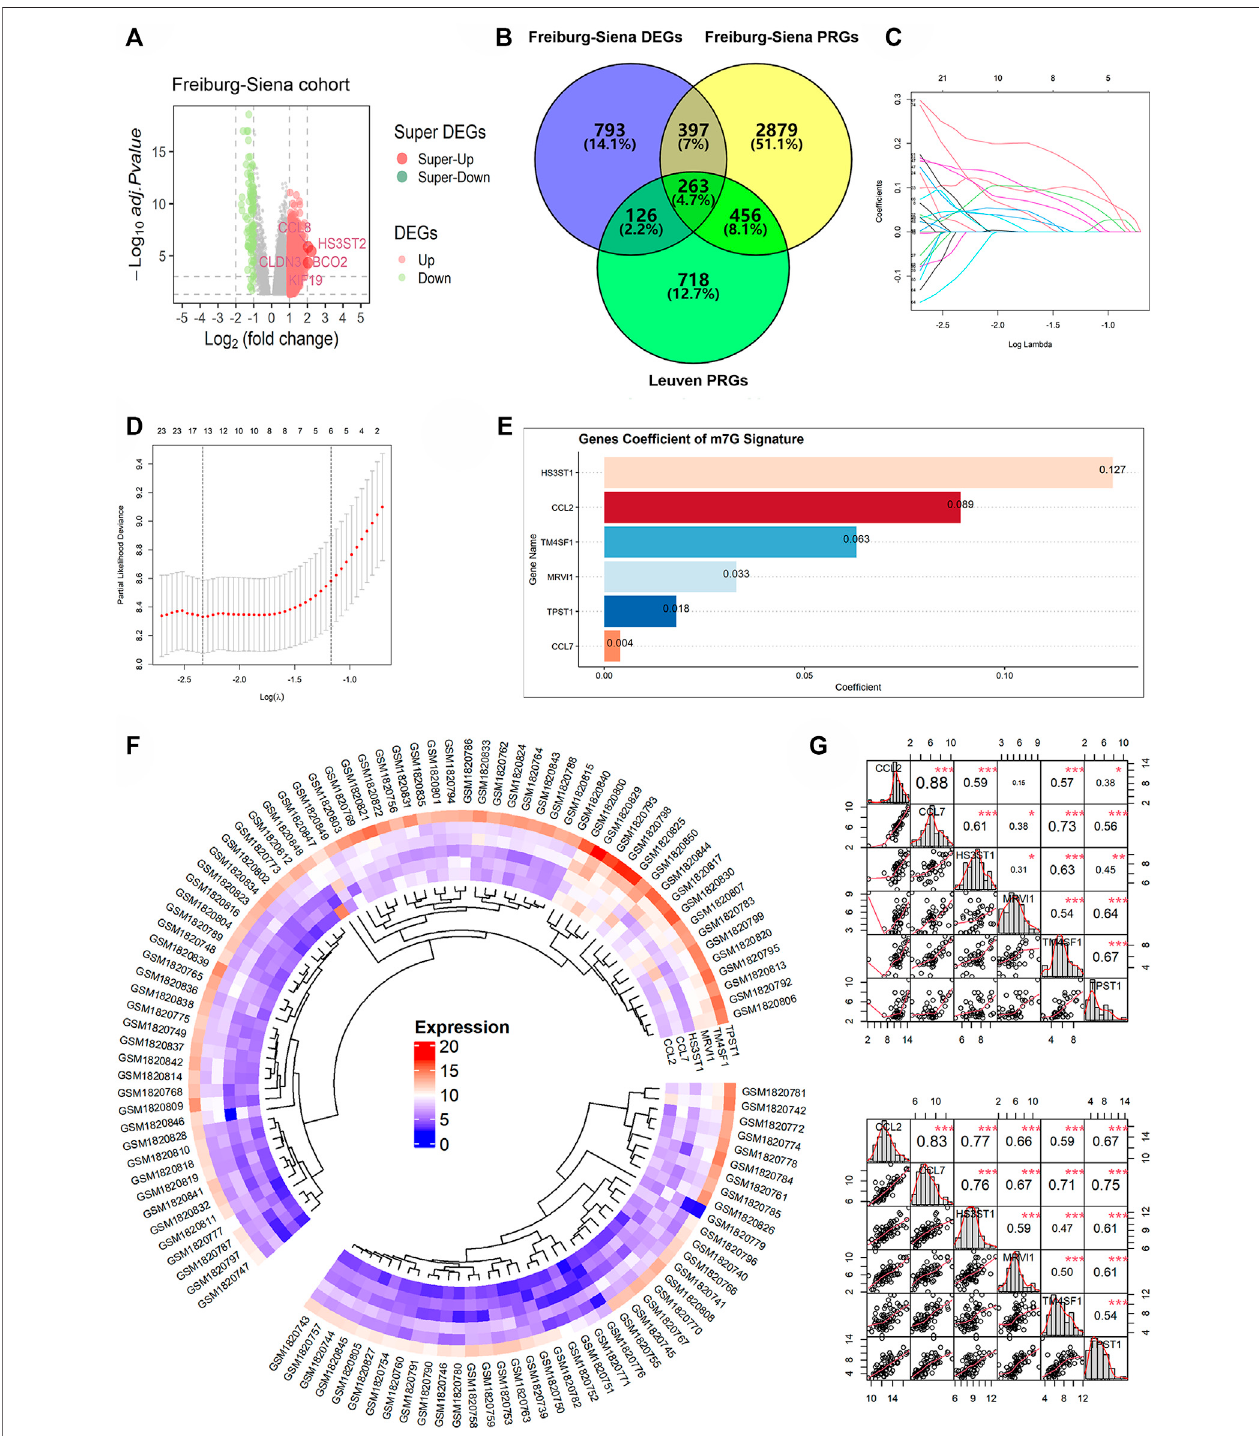
FIGURE 3 | The construction of m7GPS. (A,B) Two hundred and sixty-three genes were identi fi ed as candidate genes for m7GPS; DEGs, differentially expressed genes;PRGs,prognosis-relatedgenes. (C) Leastabsoluteshrinkageand selection operator (LASSO)coef fi cientpro fi les ofthe263candidategenes. (D) Thecoef fi cient pro fi leplotwasproducedagainstthelog(lambda)sequenceintheLASSOmodel,andtheoptimalparameter(lambda)wasselectedwhenthegenenumberequals6. (E) Coef fi cients of six genes in m7GPS. (F) Differential expression levels of six genes between the subtype 1 group (the smaller fan-shaped region) and the subtype 2 group(thelargerfan-shapedregion);the “ complete ” clusteringmethodof “ phearmap ” packagewasusedinthispanel. (G) Co-expressionrelationshipofsixgenesinthe subtype 1group(the top panel) and the subtype 2group (the bottom panel); Spearman correlationcoef fi cient wasused in thispanel; * p < 0.05; ** p < 0.01; *** p < 0.001.